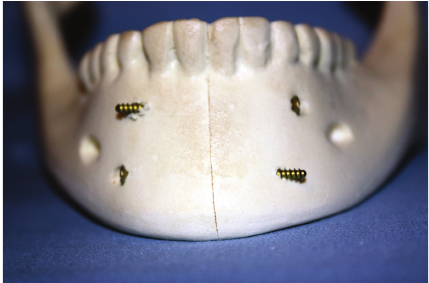
Figure 5: Lag screw (LS)